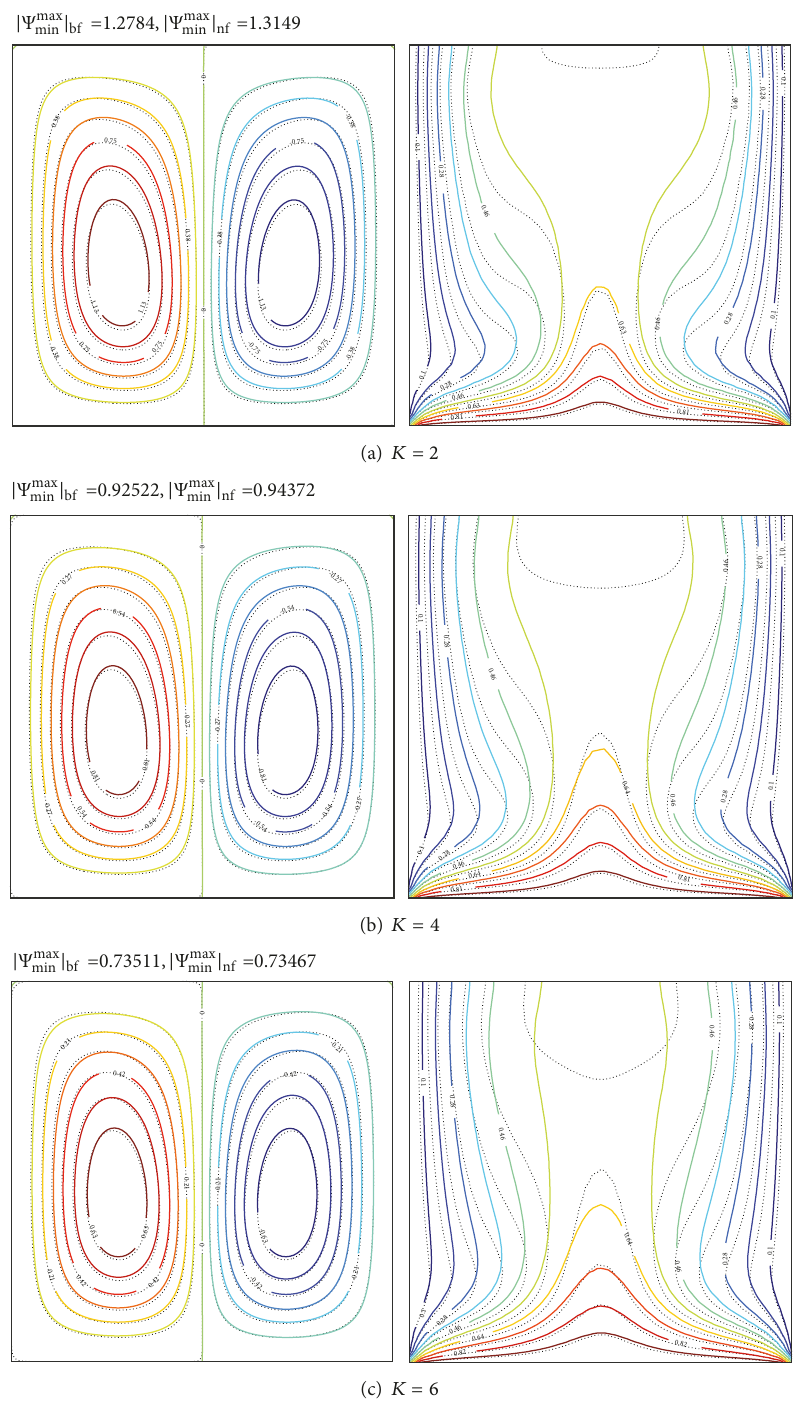
Figure 4: Streamlines and isotherms evolutions of nanoliquid (solid lines) and base liquid (dashed lines) by varying the material parameter for continuous heating corresponding to case 1 at 𝐺 = 1.0